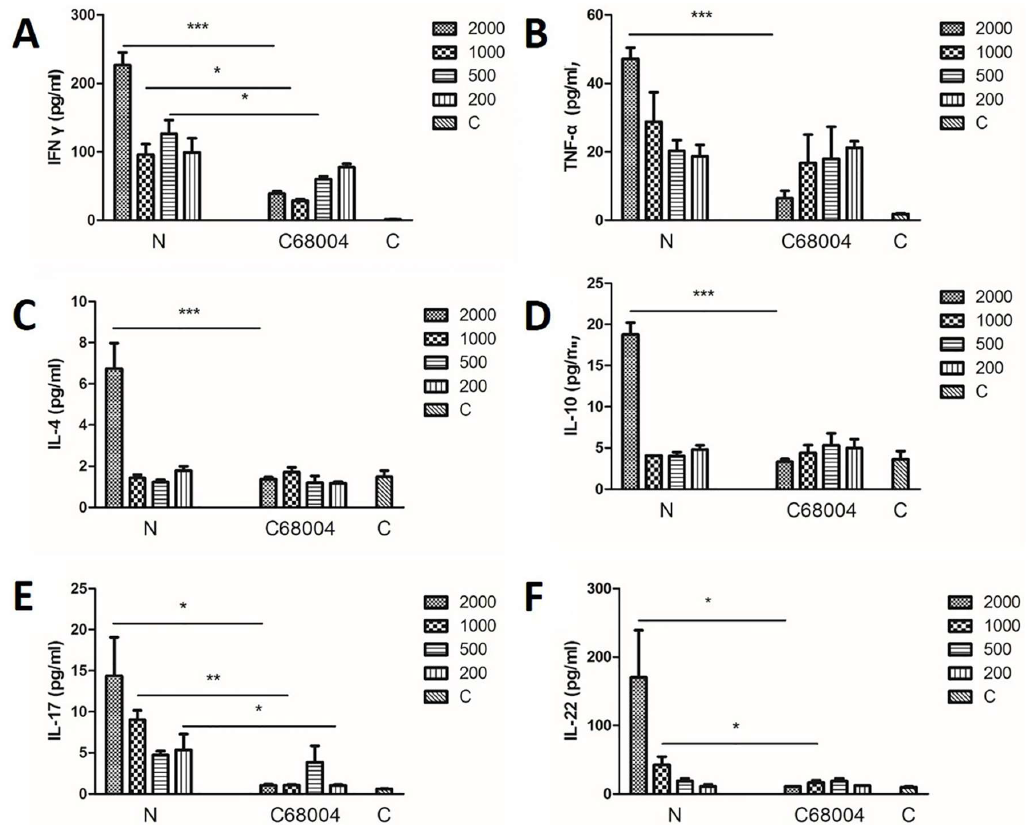
Figure 6 . Cytokines expression profiles in mice infected with different CFU of M. bovis N and M. bovis C68004 strains. The blood was harvested ante - mortem via eye route and serum was used for cytokines expression analysis. Th1 immune response cytokines shown are IFN-γ ( A ) and TNF-α ( B ). Th2 immune response cytokines shown are IL-4 ( C ) and IL-10 ( D ). Th17 immune response cytokines (two-tailed). Bars represent means SEM ( n = 6); * p < 0.05, ** p < 0.01; *** p <